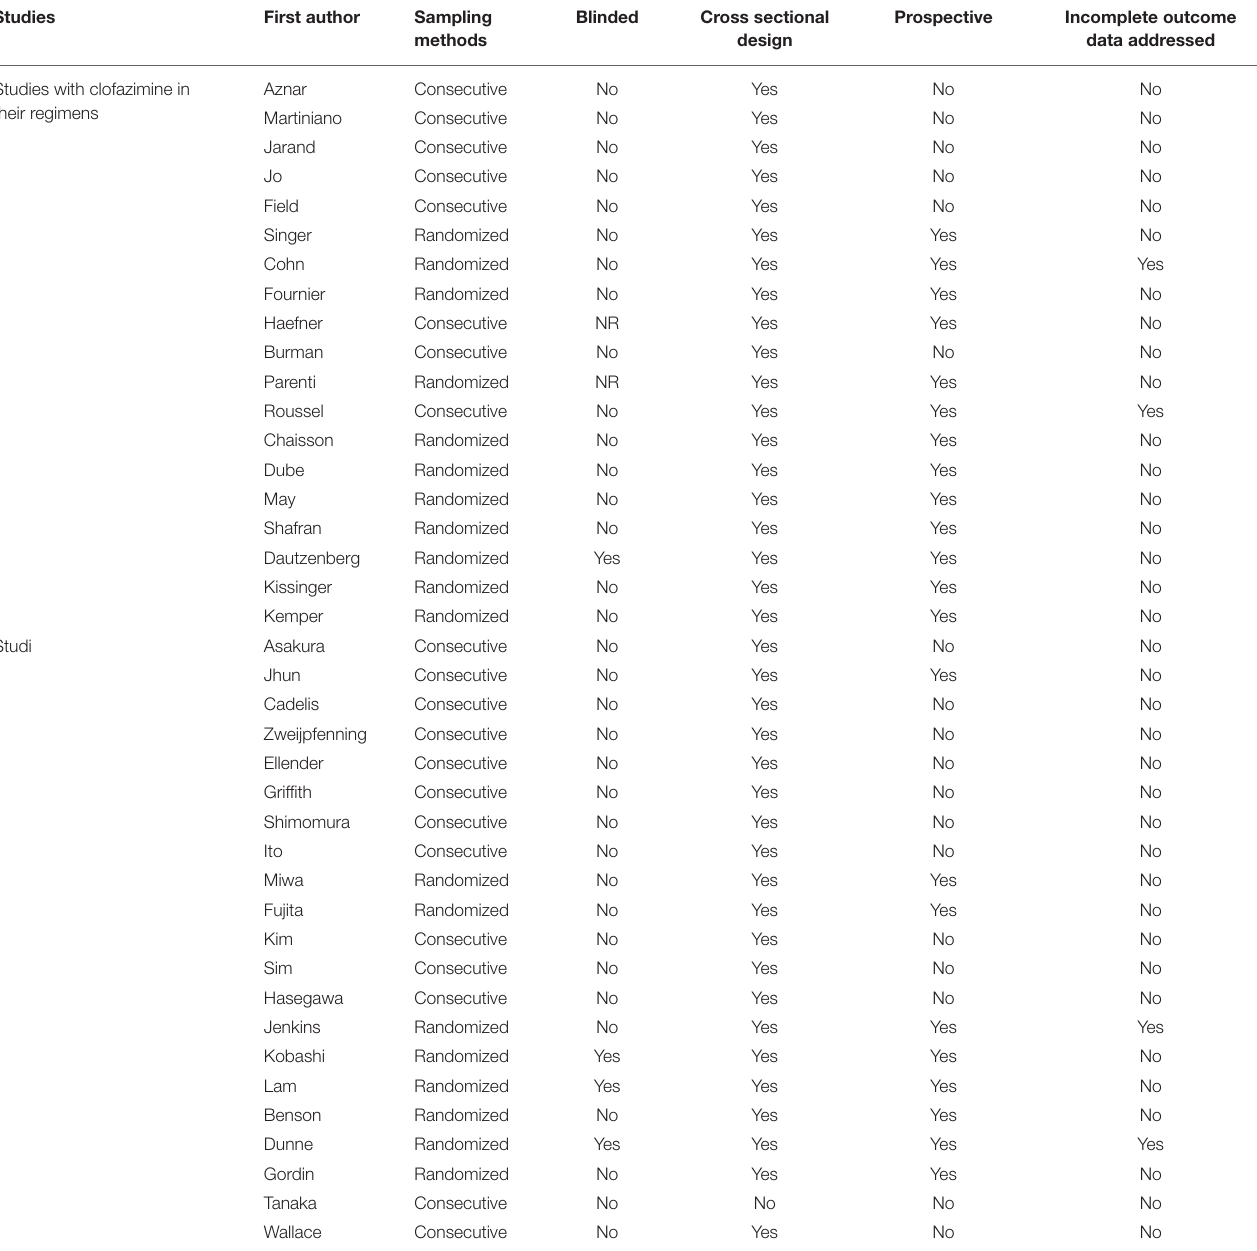
TABLE 3 | Assessment of study